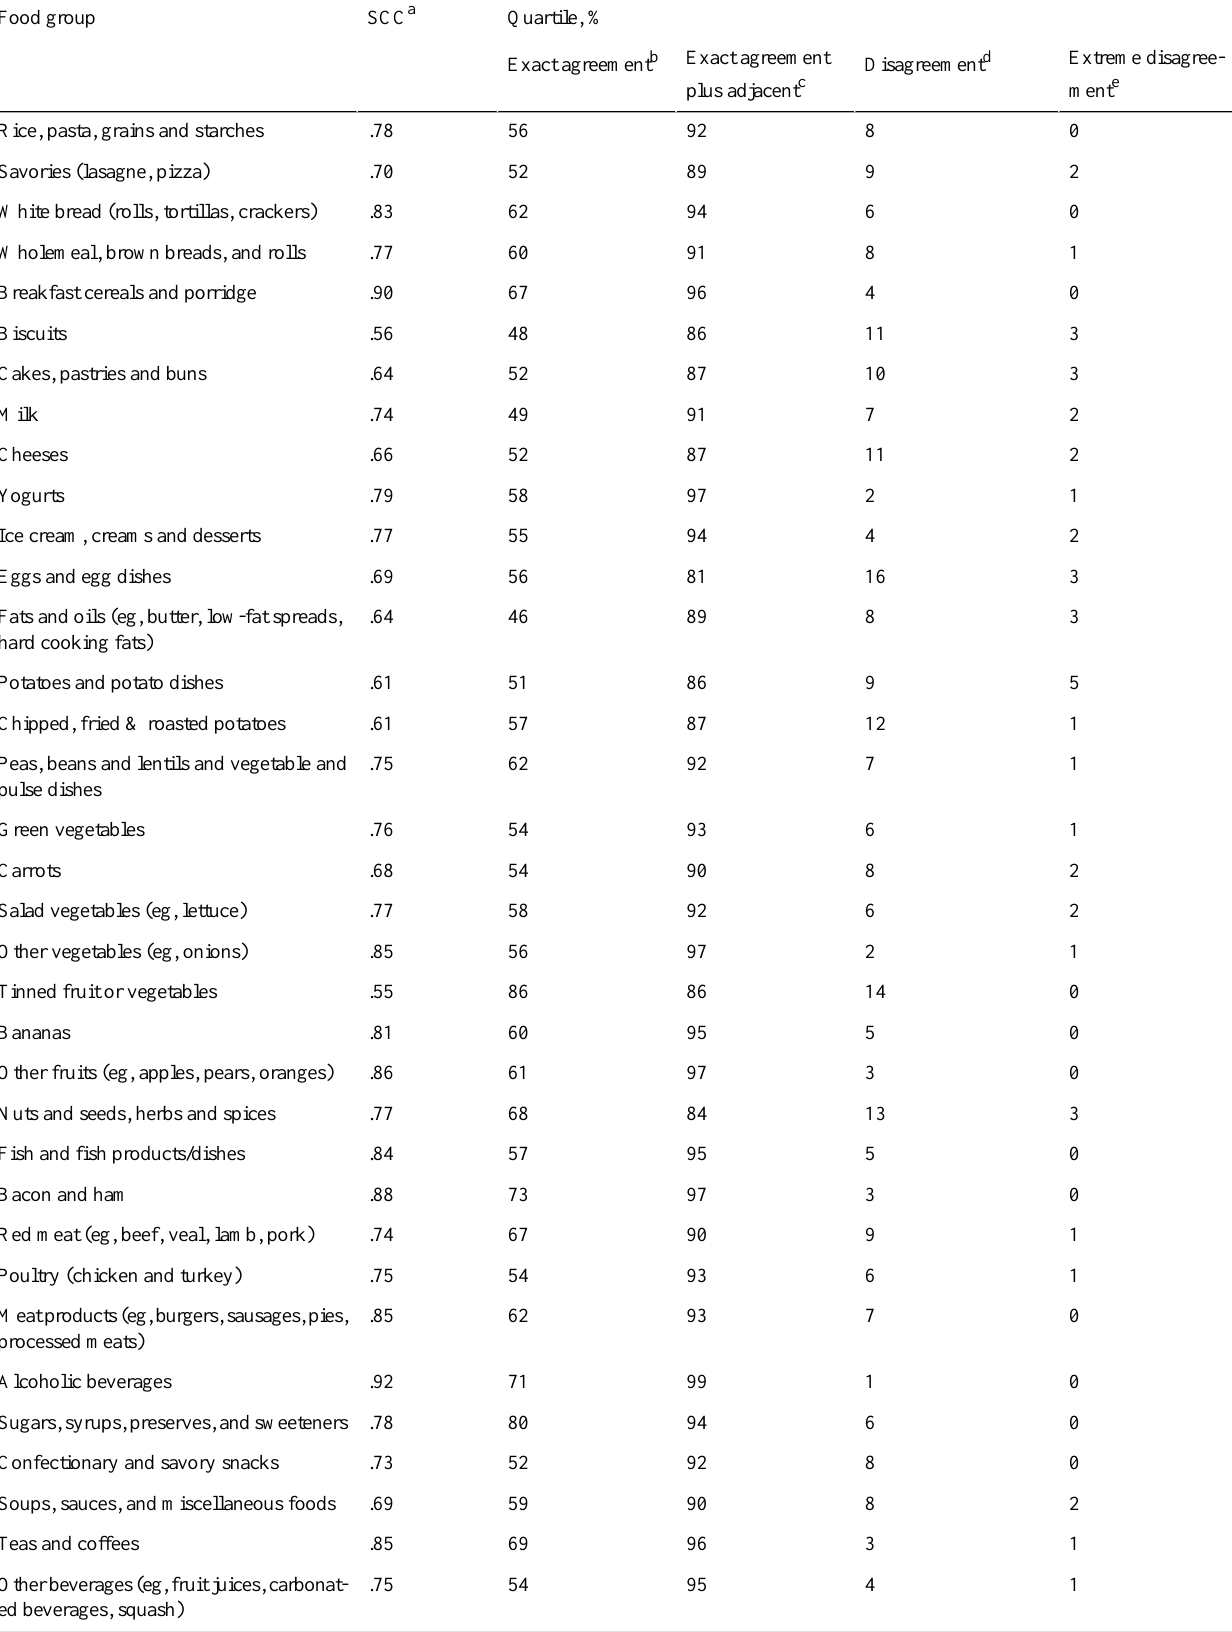
Table 4. Spearman correlation coefficients (SCC) and cross-classification of quartiles of food group intake derived from repeat measures of the online Food4Me FFQ